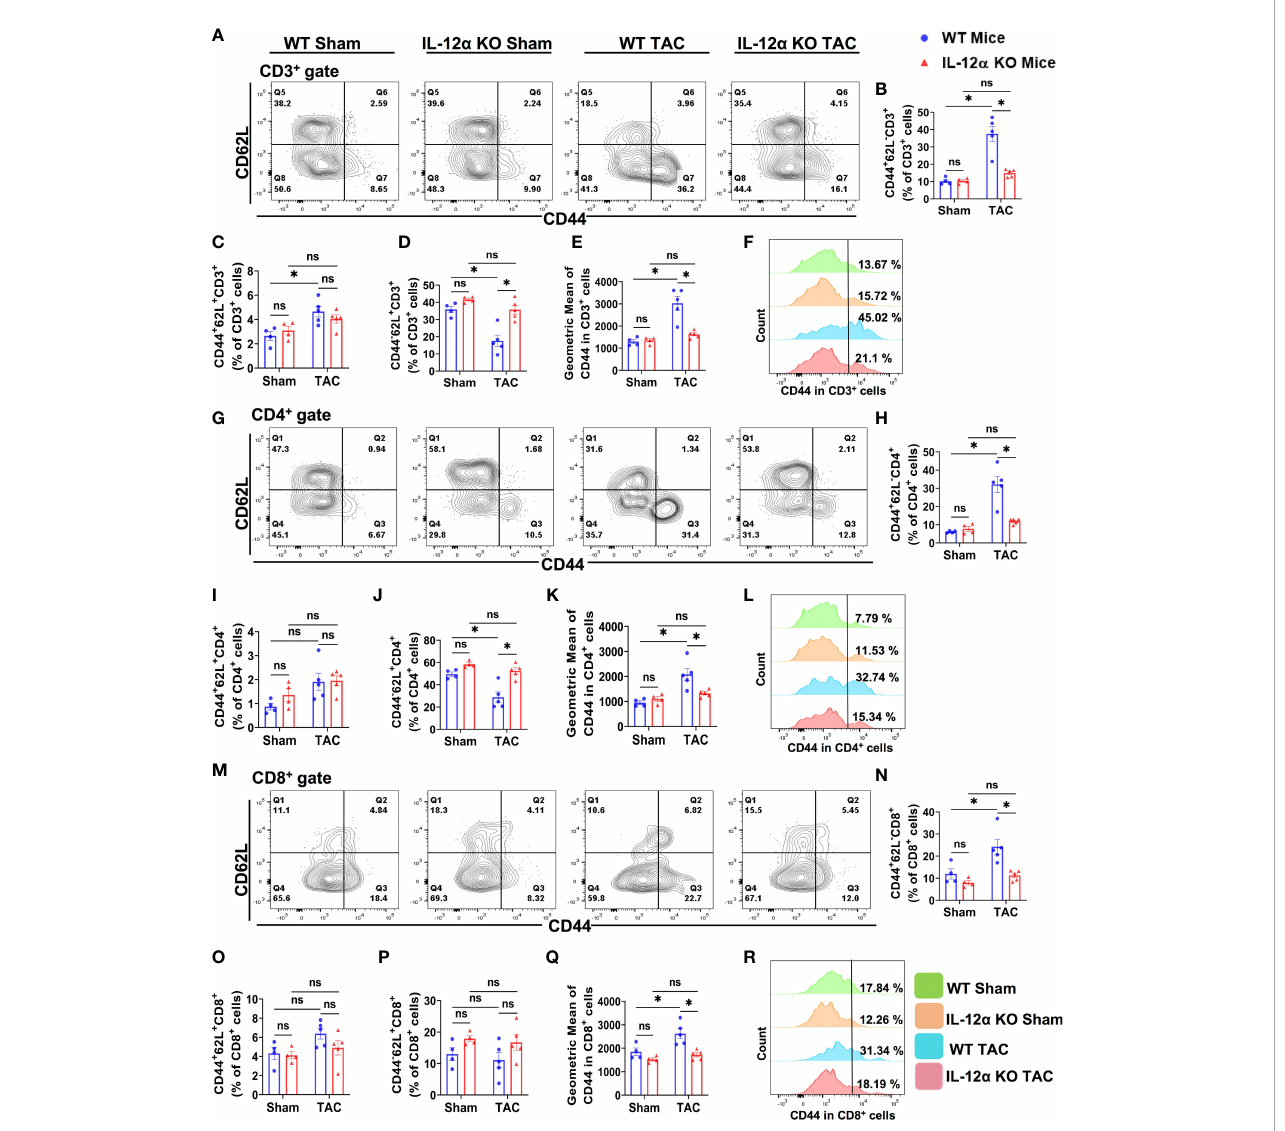
FIGURE 9 IL-12 a KO signi fi cantly attenuated TAC-induced T cell activation in the lung. (A) Representative plots detecting activation status of CD3 + T cells. (B – D) Percentages of CD44 + CD62L - effector memory cells, CD44 + CD62L + central memory cells, and CD44 - CD62L + naïve cells within CD3 + T cells, respectively. (E) Quanti fi ed mean fl uorescent intensity of CD44 in CD3 + T cells. (F) Representative histograms of CD44 expression within CD3 + T cells. (G) Representative plots detecting activation status of CD4 + T cells. (H – J) The percentages of CD44 + CD62L - effector memory cells, CD44 + CD62L + central memory cells, and CD44 - CD62L + naïve cells within CD4 + T cells, respectively. (K) Mean fl uorescent intensity of CD44 in CD4 + T cells. (L) Representative histograms of CD44 expression within CD4 + T cells. (M) Representative plots detecting activation status of CD8 + T cells. (N – P) The percentage of CD44 + CD62L - effector memory cells, CD44 + CD62L + central memory cells, and CD44 - CD62L + naïve cells within CD8 + T cells, respectively. (Q) Mean fl uorescent intensity of CD44 in CD8 + T cells. (R) Representative histograms showing CD44 expression within CD8 + T cells. *p<0.05, ns, non-signi fi